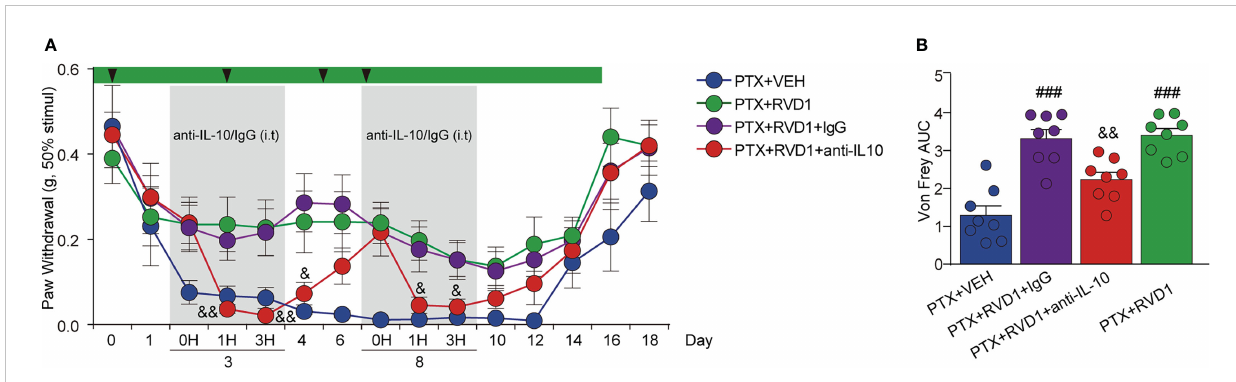
FIGURE 6 The analgesic effect of RvD1 on PINP is dependent of IL-10. On the 3rd and 8 th day of PTX administration, mice were injected (i.t.) with IL-10 neutralizing antibody and IgG (2 m g). Mechanical pain threshold was determined using von Frey test (A) , AUC analysis was shown in (B) . ###p<0.001